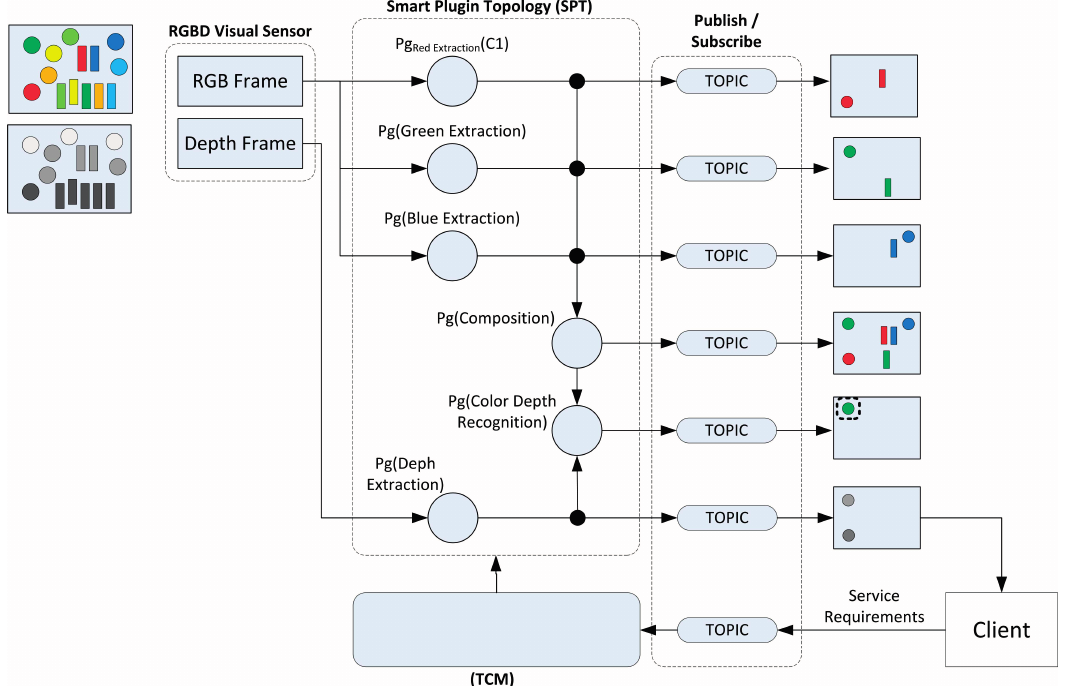
Figure 6. Plugins